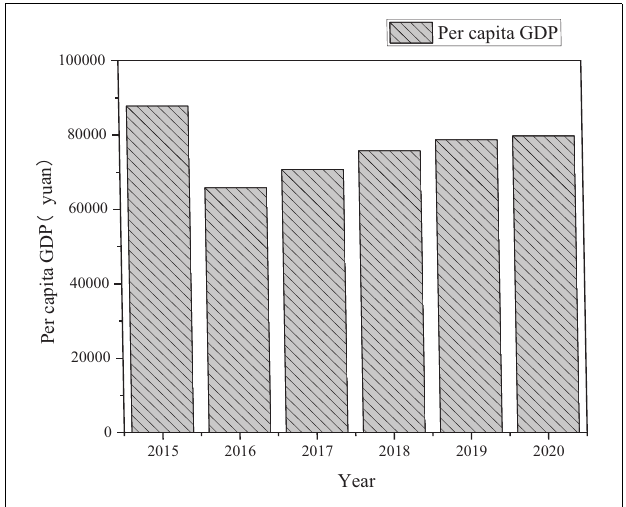
FIGURE 7 | Output ratio of human capital stock in Shenyang from 2015 to